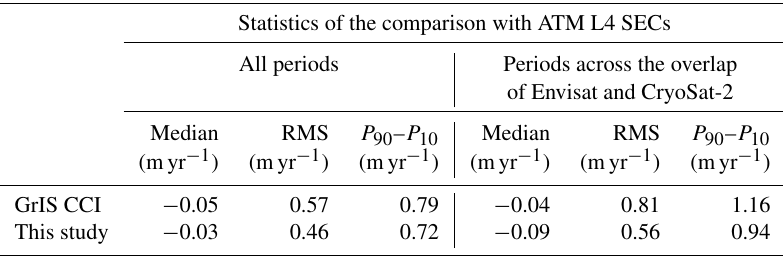
Figure 11. Validation with GrIS CCI SECs: (a) median, (b) RMS error, and (c) P 90 – P 10 of the SEC differences between CCI (orange) and those derived from our merged time series (green) at 5-year intervals during 1992–2019. Table 2. Statistics of the results of validation with GrIS CCI SECs. The median, RMS error, and P 90 – P 10 of the biases are